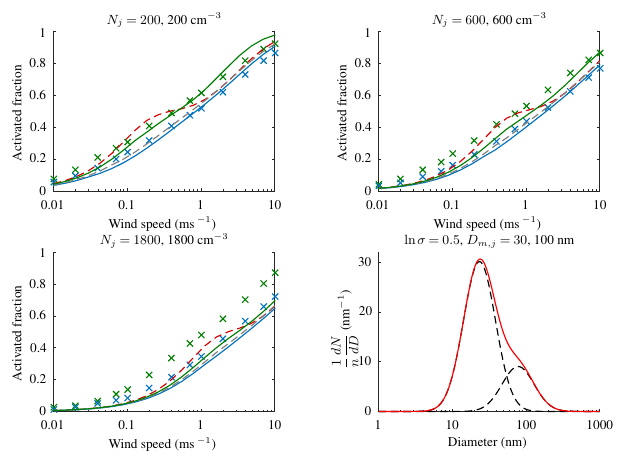
Figure 5. Same as Fig. 3 but with a different size distribution.